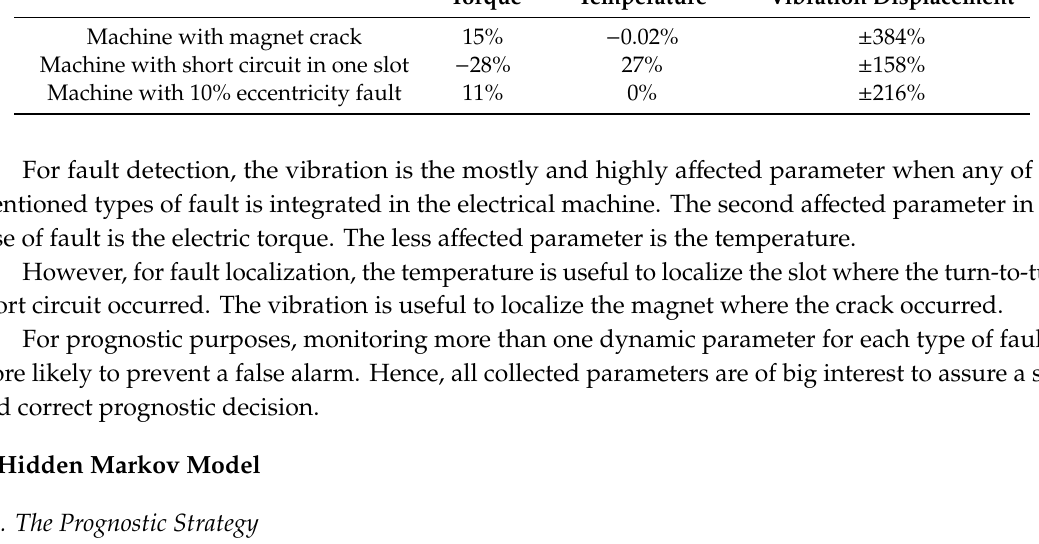
Figure 17. Vibration in time domain (machine with turn-to-turn short circuit in one slot).